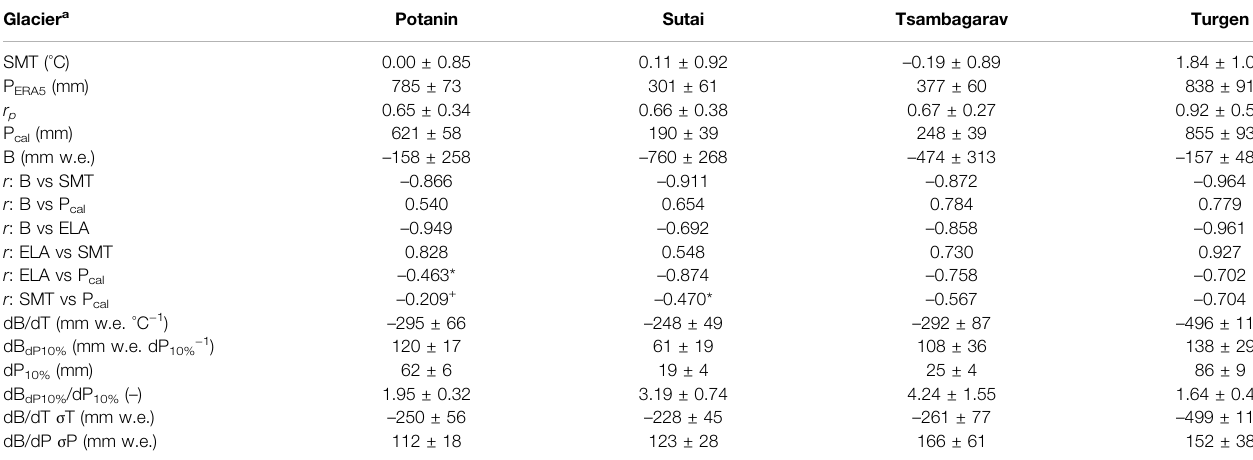
TABLE 3 | Climate, parameter, correlation, and sensitivity of the long-term (1980 – 2018) reconstructed mass balance of four studied glaciers in Mongolia. Glacier a